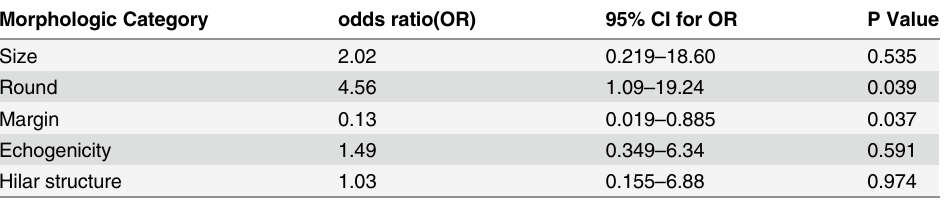
Table 2. Logistic regression analysis of EBUS image categories for the prediction of RLN lymph node metastases compared surgical